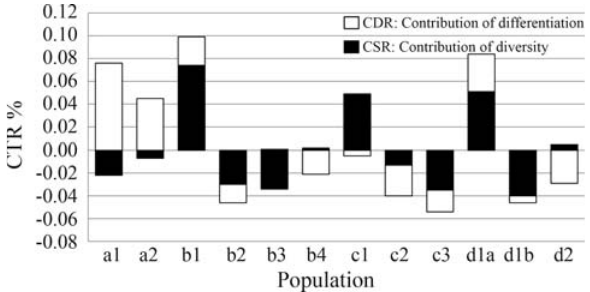
Figure 2 - The contribution of each Channa striata population to total di- versity ( CTR ), as described by allelic richness. White bars represent the contribution of differentiation ( CDR ) and black the contribution of diver- sity ( CSR